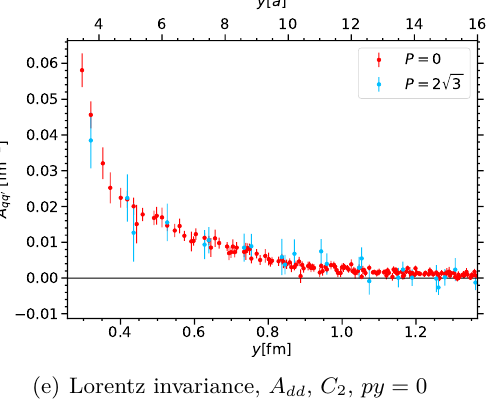
Figure 9 . Comparison of the twist-two data for P = 0 (red), P = This is shown for the C A δuu (d) and A dd (e). In the latter case we leave out the data for P = have large statistical